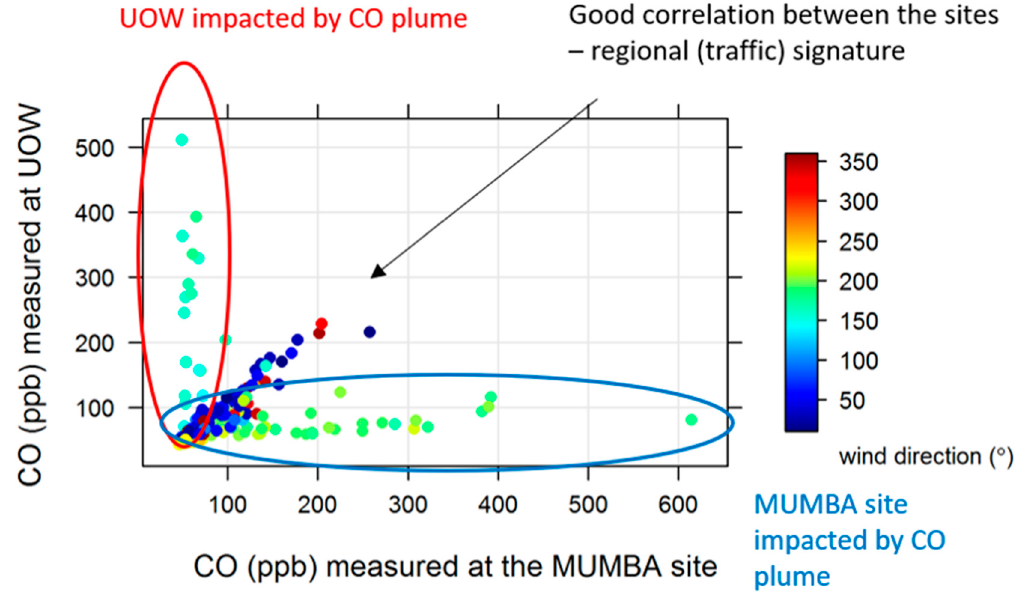
Figure 8. CO measured at the University of Wollongong (UOW) site plotted against coincident CO measured at the main MUMBA site. The plot is coloured by wind direction measured at the MUMBA site.